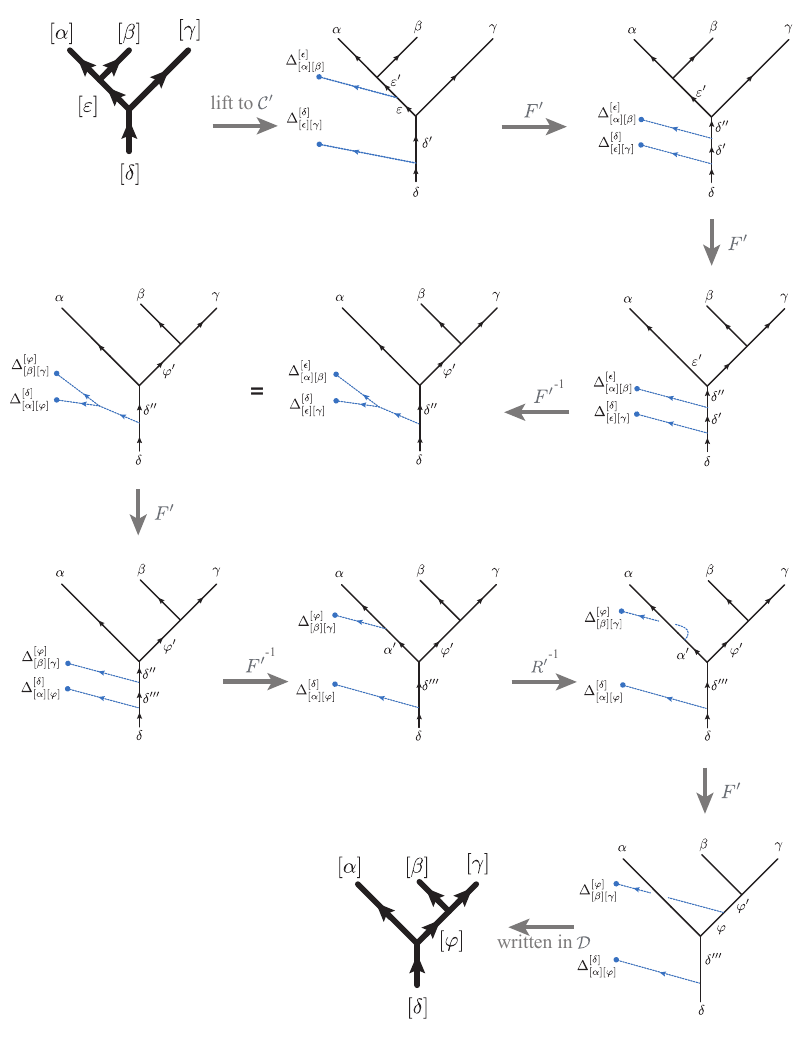
Figure 2: A single F -move in the cateory ˜ D , when lifted to the parent category C (cid:48) , consists of a sequence of F - and R -moves in C